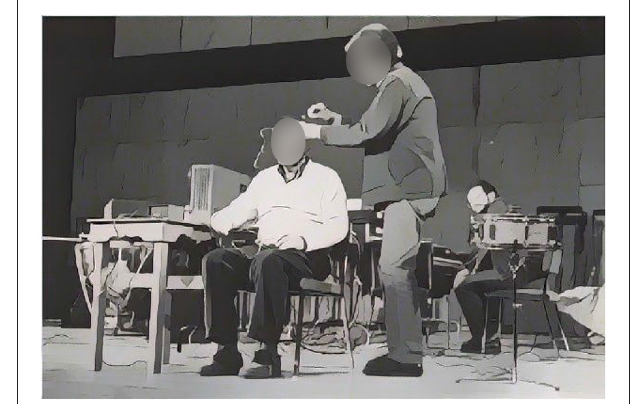
FIGURE 1 | Physicist Edmond Dewan and composer Alvin Lucier collaborated on music for the solo